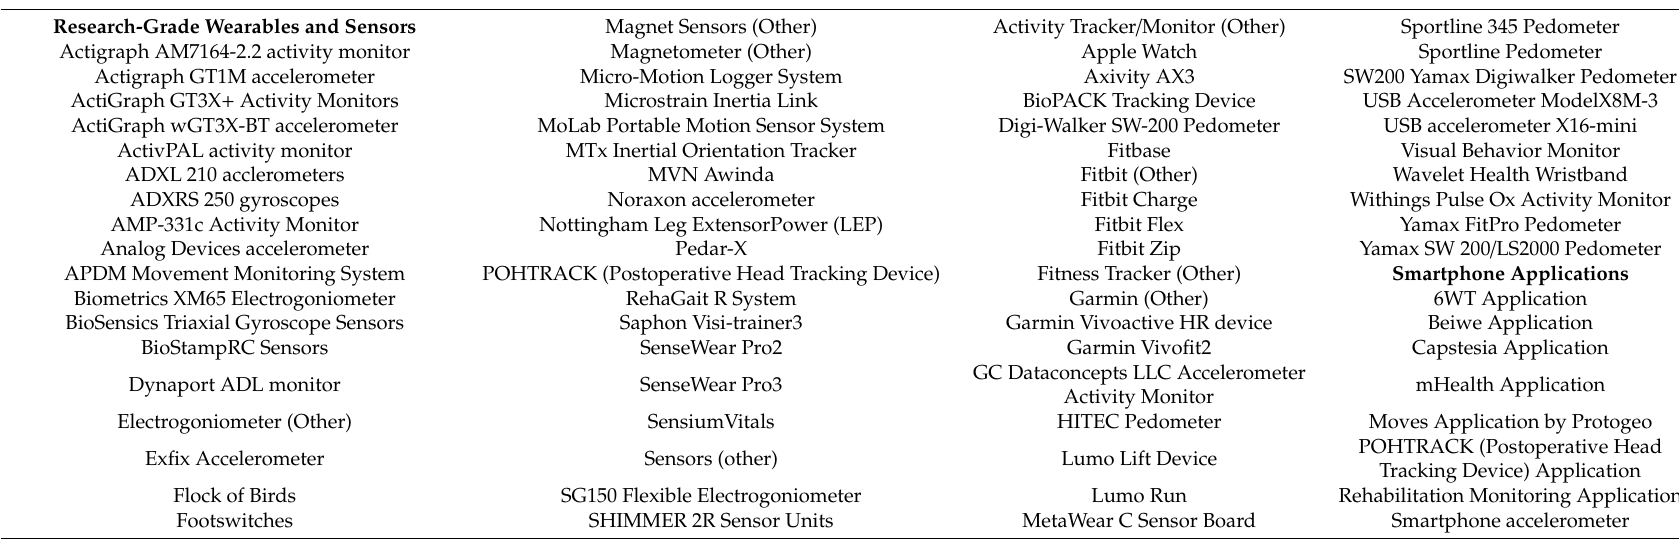
Table A4. Technologies including Activity Trackers, Smartphone Applications, Research- / Commercial-grade wearables, Other Sensors. Research-Grade Wearables and